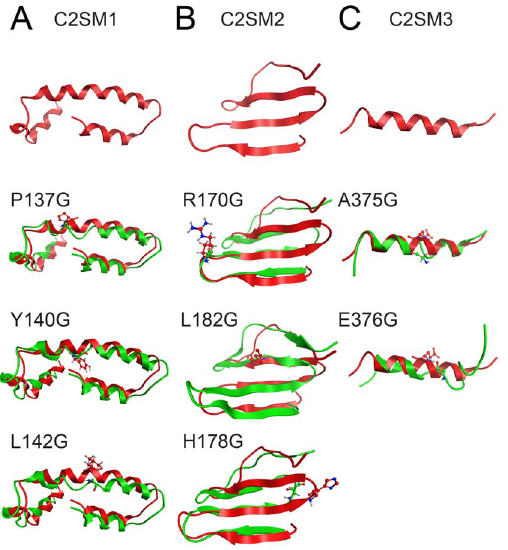
Figure 6. Insilico analysis of the conserved motifs C2SM1-3 and the consequences of introducing the mutations. 3D molecular modeling study of the three conserved motifs in Clr2. C2SM1 (A), C2SM2 (B) and C2SM3 (C). Mutating the conserved amino acids in Clr2 was predicted to disrupt the secondary structure of the protein. Overlay between the predicted wild type structure in red and the simulated post-MD mutant protein conformation in green color.